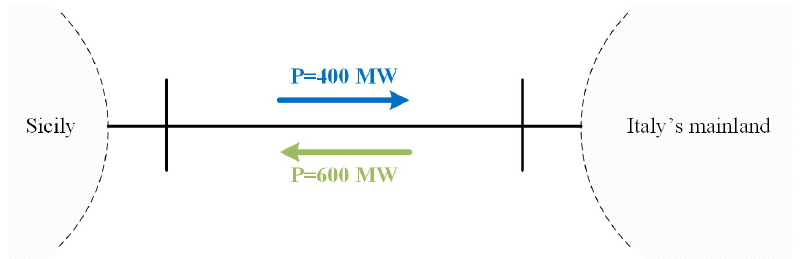
Figure 8. Two different system operating conditions of power flow between Sicily and Italy’s mainland. Blue: power flow of P = 400 MW from Sicily to Italy’s mainland. Green: power flow of P = 600 MW from Italy’s mainland to Sicily.